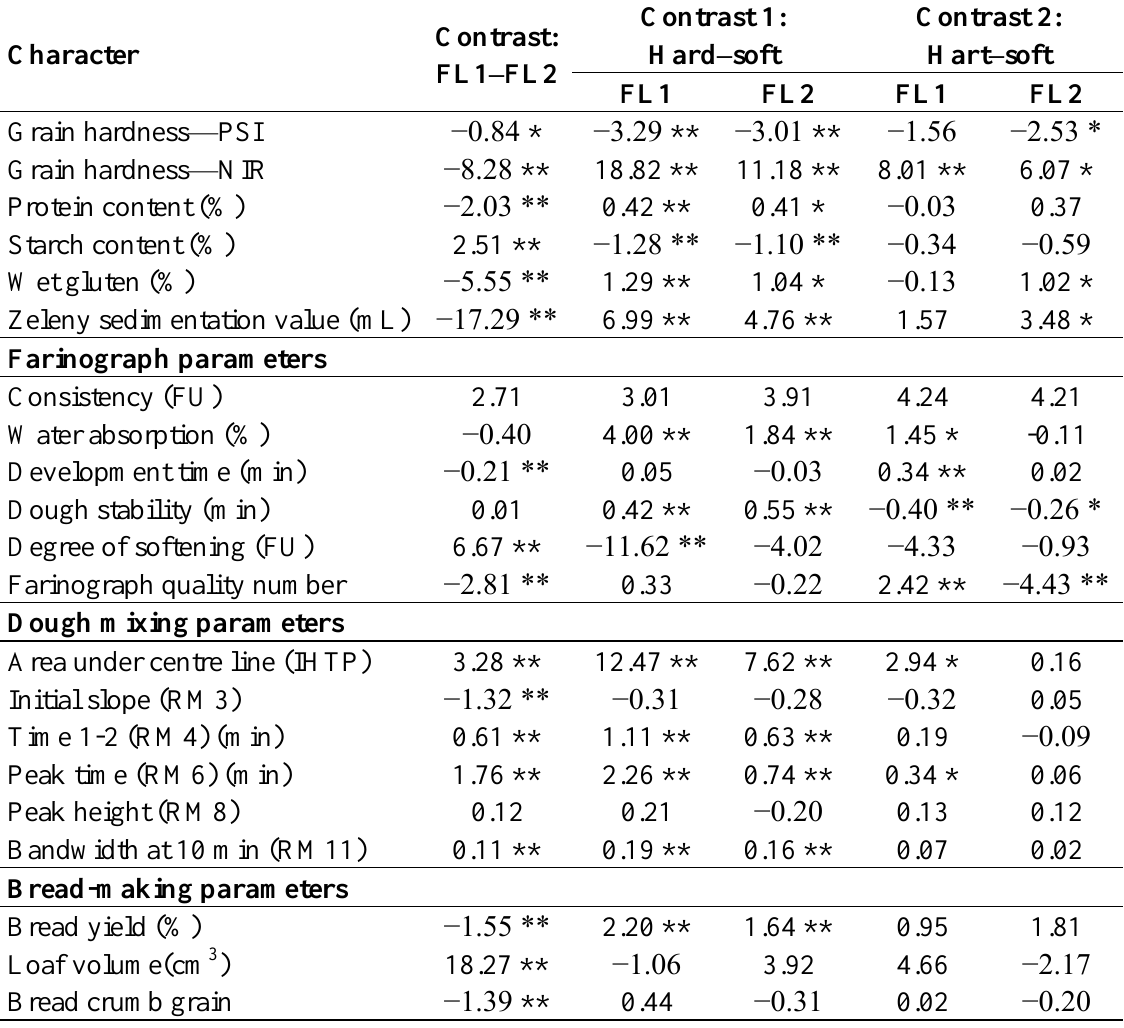
Table 4. Estimates and results of testing contrasts between hard- and soft-grained wheat lines for quality characteristics at two fertilization levels (FL1,